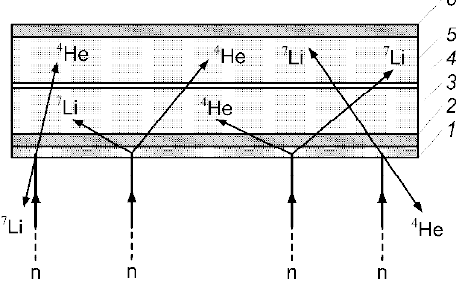
Fig. 1. 10 B 2D detector concept. 1 – 10 B - layer, 3 μm; 2 – Al - layer, 0.2 μm; 3 – 1-st sensitive gas gap of 2 mm thickness; 4 – WRe - wires, 20 μm; 5 – 2-nd sensitive gap of 2 mm thickness; 6 – 2 mm thickness fiberglass.